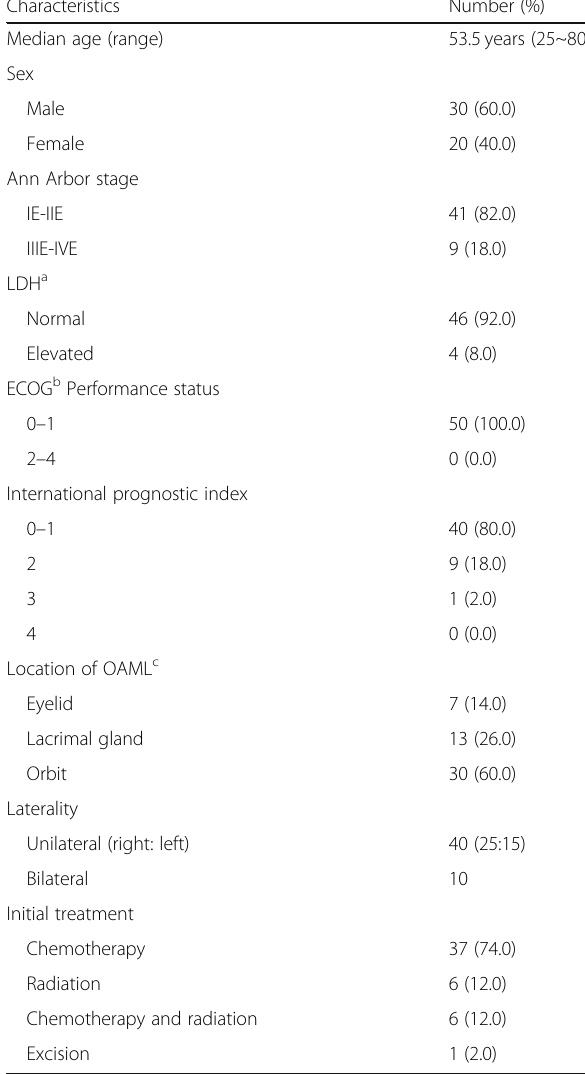
Table 1 Patient characteristics Characteristics